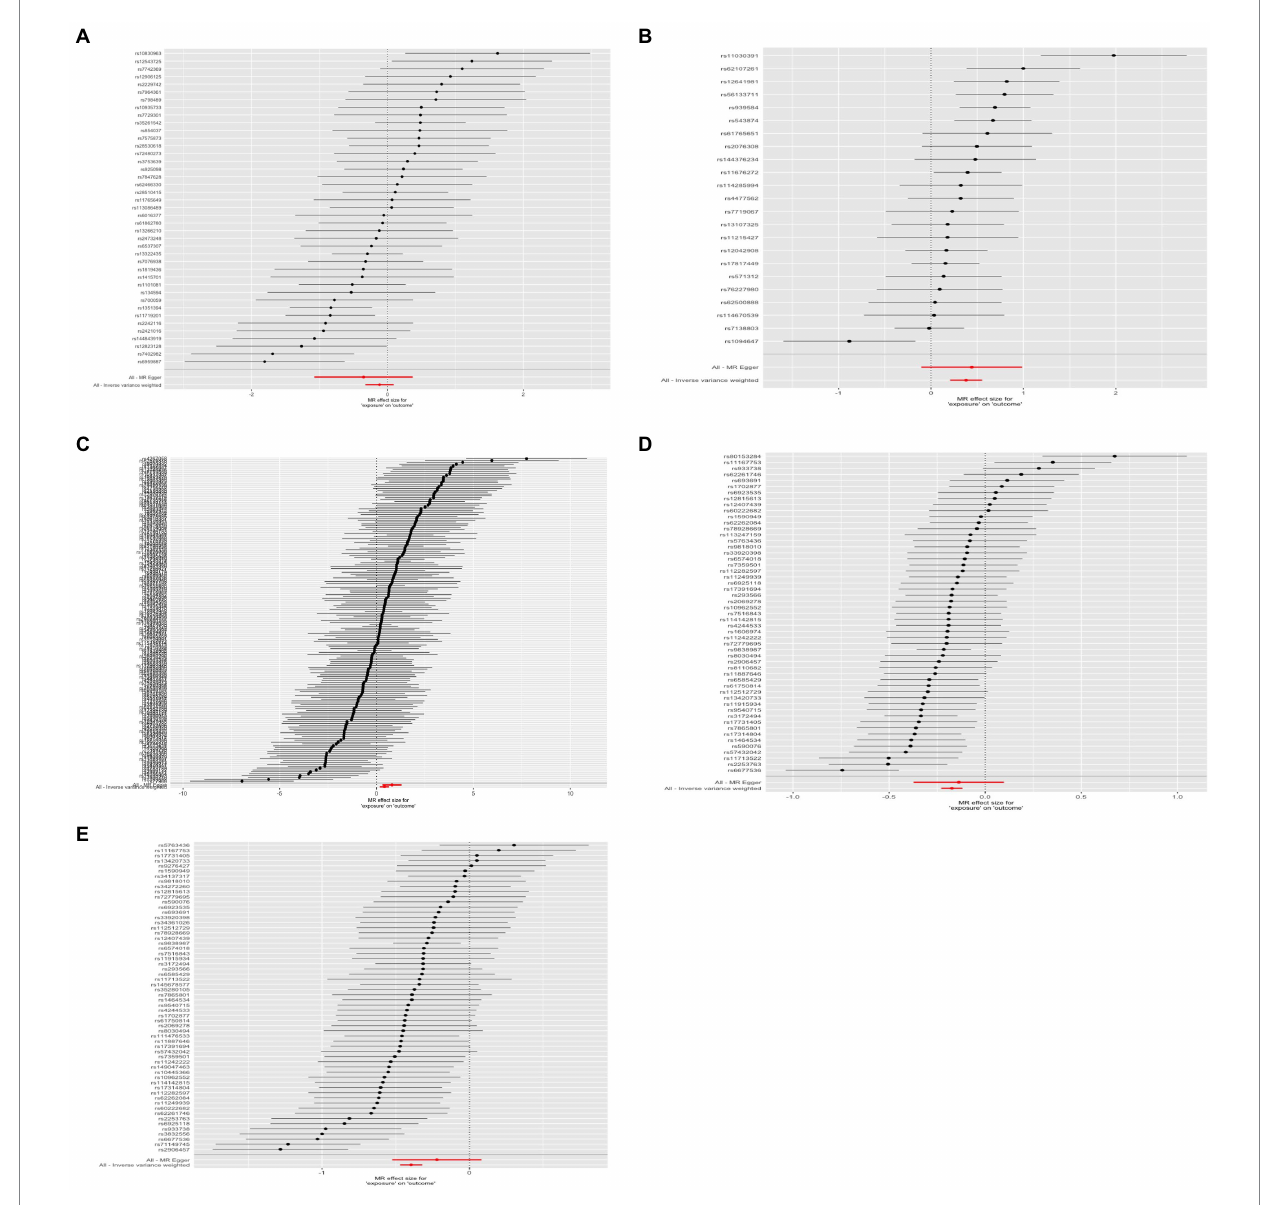
FIGURE 3 Results of the forest plot. (A) Lower birth weight (BW)-Alzheimer’s disease (AD); (B) childhood body mass index (BMI)-attention-deficit hyperactivity disorder (ADHD); (C) early life body size-ADHD; (D) age at first birth (AFB)-major depressive disorder (MDD); (E) AFB-ADHD; the solid dot means the causal effects of exposure on outcomes with four methods [MR-Egger (MRE); weighted median (WM); weighted mode (Wm); inverse-variance weighting (IVW); MR-Egger and Mendelian Randomization Pleiotropy RESidual Sum and Outlier (MR-PRESSO)]. The results of the binary outcomes are shown by OR [95%CI]. Numbers in bold mean P- values <5.00E-02, and italic and bold font means P- values